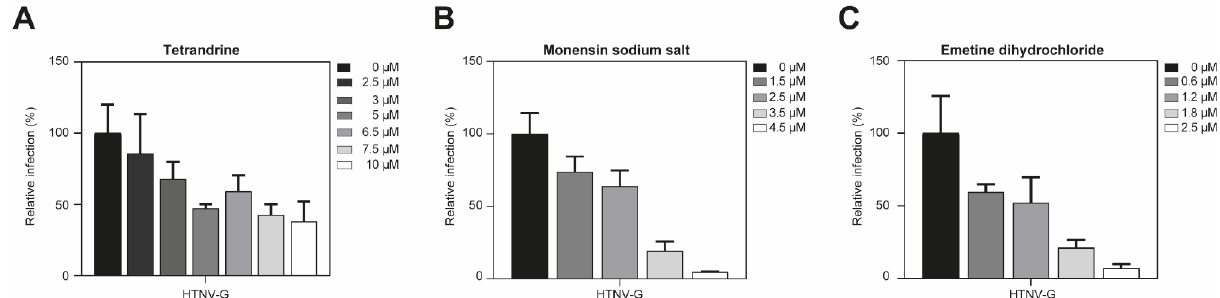
Figure 6. Treatment with tetrandrine, monensin sodium salt and emetine dihydrochloride in Vero E6 cells. ( A – C ) Monolayers of Vero E6 cells were pre-treated with the indicated drugs at given concentrations and then infected with VSV* Δ G- Luc(HTNV-G). After 90 min, cells were washed and complete medium with 20 mM ammonium chloride was added and further incubated for 16 h. The infection levels were assessed by counting the EGFP-positive infected cells. Data are means + SD ( n = 3).